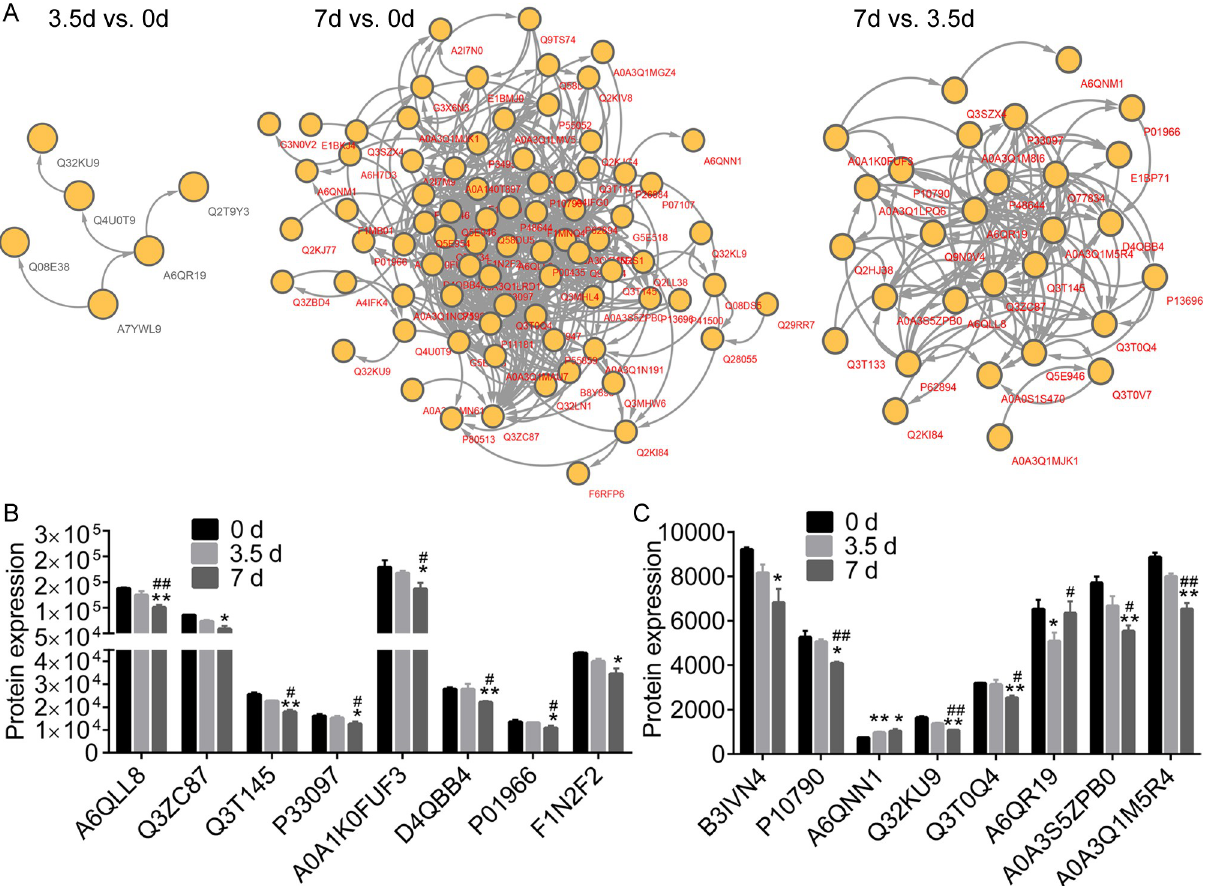
Fig 5. The Protein-Protein Interaction (PPI) network and expression profiles. (A), the PPI network of the differentially expressed proteins (DEPs) between different time points. (B and C), the expression profiles of several DEPs in meat samples post storage at 4˚C. � and �� notes p < 0.05 and p < 0.01 vs. 0 d, respectively. # and ## indicates p < 0.05 and p < 0.01 vs. 3.5 d,